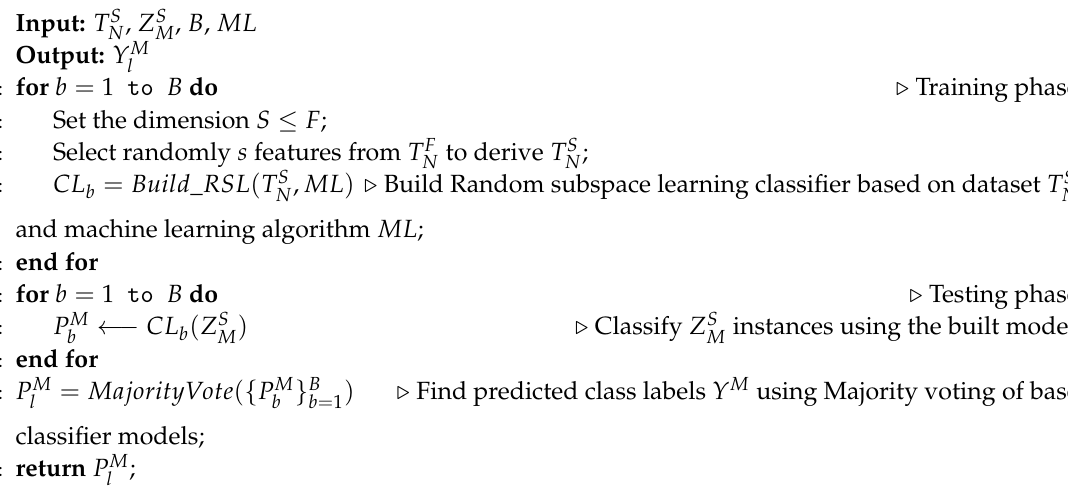
Algorithm 1 Random Subspace learning